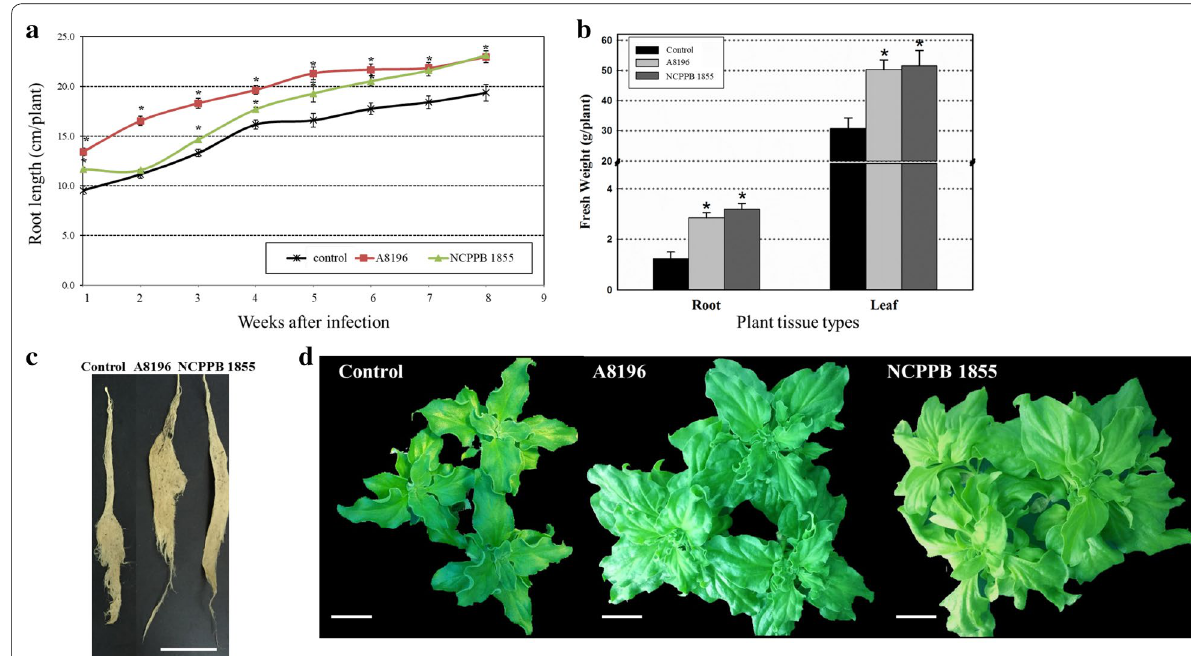
Fig. 5 The growth of hydroponically grown ice plants after infection by A. rhizogenes strains. a Root length of mock control, A. rhizogenes A8196‑ or NCPPB 1855‑infected plants was measured every week for 8 weeks. *P < 0.05 comparing A. rhizogenes ‑infected plants and mock control based on pairwise Student t ‑test. b Fresh weight of roots and aerial parts (leaf) of infected plants measured after 8‑week infection. About 16–20 ice plants were infected with each A. rhizogenes strain for each independent transformation assay. Average values of the fresh weights from at least three independent experiments. Error bars were calculated using Excel STDEVP function. *P < 0.05 comparing A. rhizogenes ‑infected plants and mock control based on pairwise Student t ‑test. The representative root ( c ) and aerial tissues ( d ) of plants infiltrated with mock control, A. rhizogenes A8196 or NCPPB 1855 (from left to right) after 8‑week treatments. Bar 50 μm. NaCl solution used to wash and resuspend bacteria was the mock =